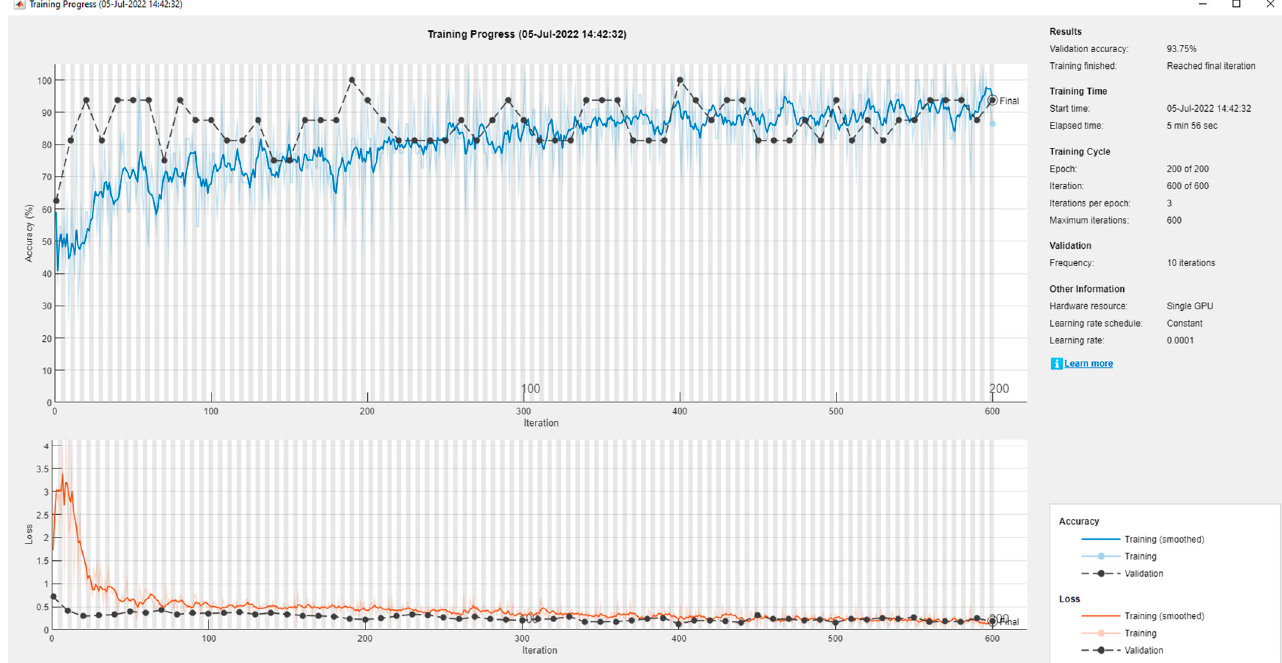
Figure 9. The training and validation chart.